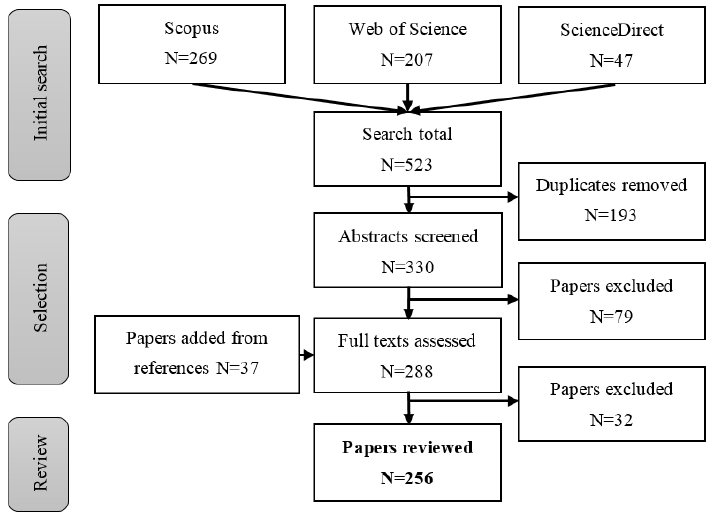
Figure 1. Flow chart illustrating the process and major steps in the literature search and selection.